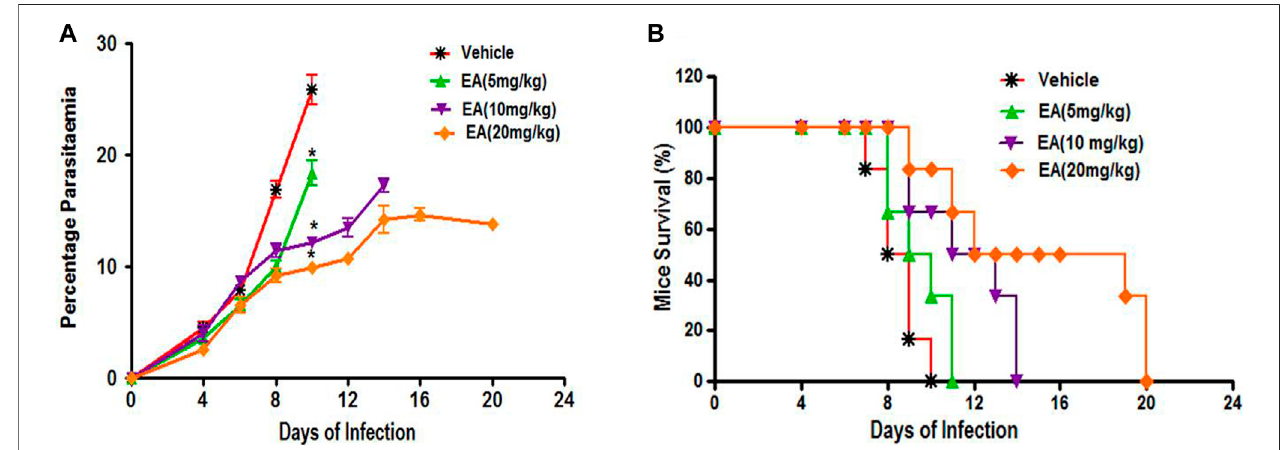
FIGURE 2 | Effect of EA on antimalarial activity in P. berghei included malaria in mice (A) Percent Parasiteman (B) Percent Survival. Data are expressed as Mean ± SEM. * P < 0.05; *Vehicle vs Treatment; n (cid:1) 6.